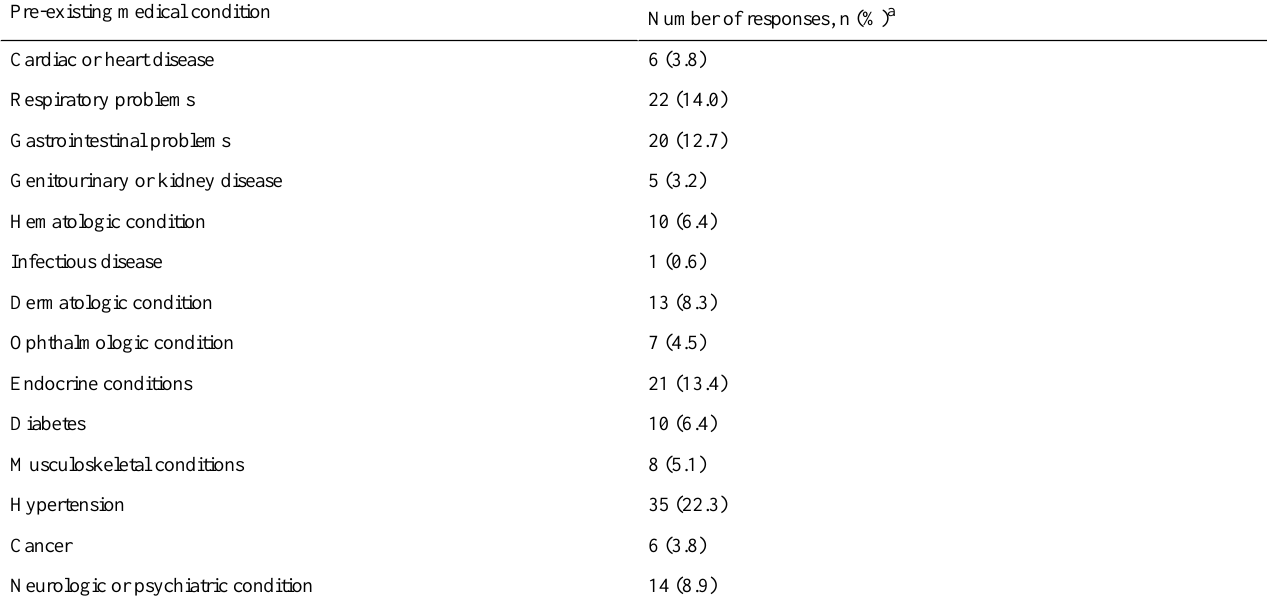
Table 2. Distribution of the responses of participants with pre-existing medical conditions